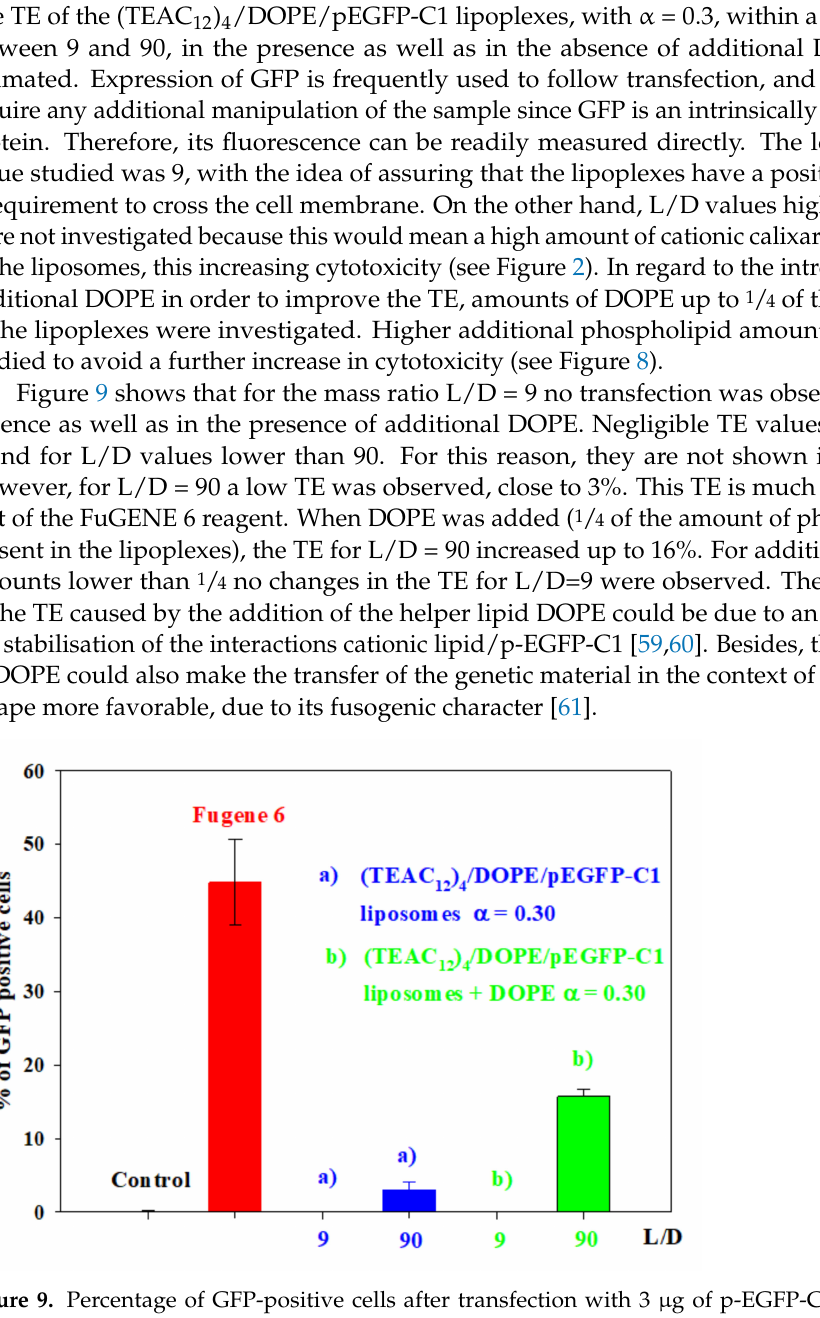
Figure 9. Percentage of GFP-positive cells after transfection with 3 µ g of p-EGFP-C1, 24 h post transfection; 10,000 cells were analyzed per condition by flow cytometry (FACS). (a) (TEAC 12 ) 4 / DOPE/pEGFP-C1 liposomes at α = 0.30; and (b) (TEAC 12 ) 4 /DOPE/pEGFP-C1 liposomes + DOPE at α =